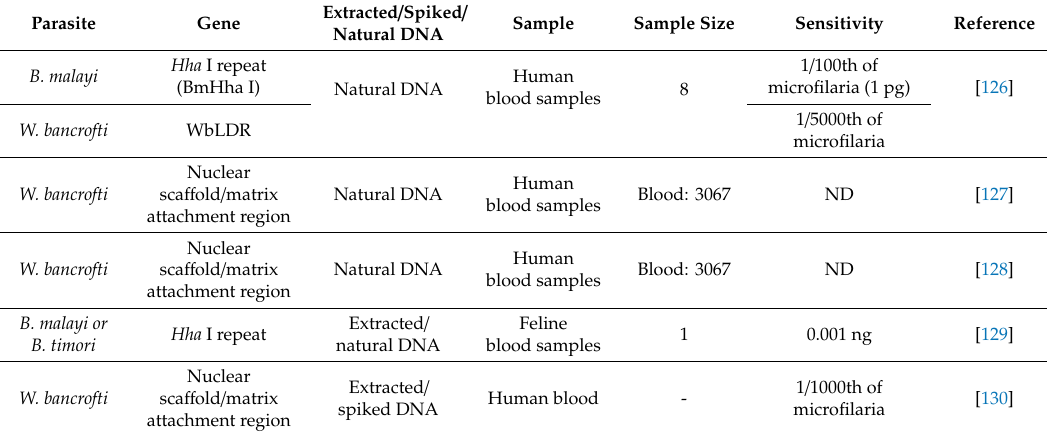
Table 10. Publications found in the US National Library of Medicine National Institutes of Health (NCBI-PubMed) reporting the standardisation of the LAMP technique as a useful tool for diagnosing lymphatic filariasis in the definitive host.